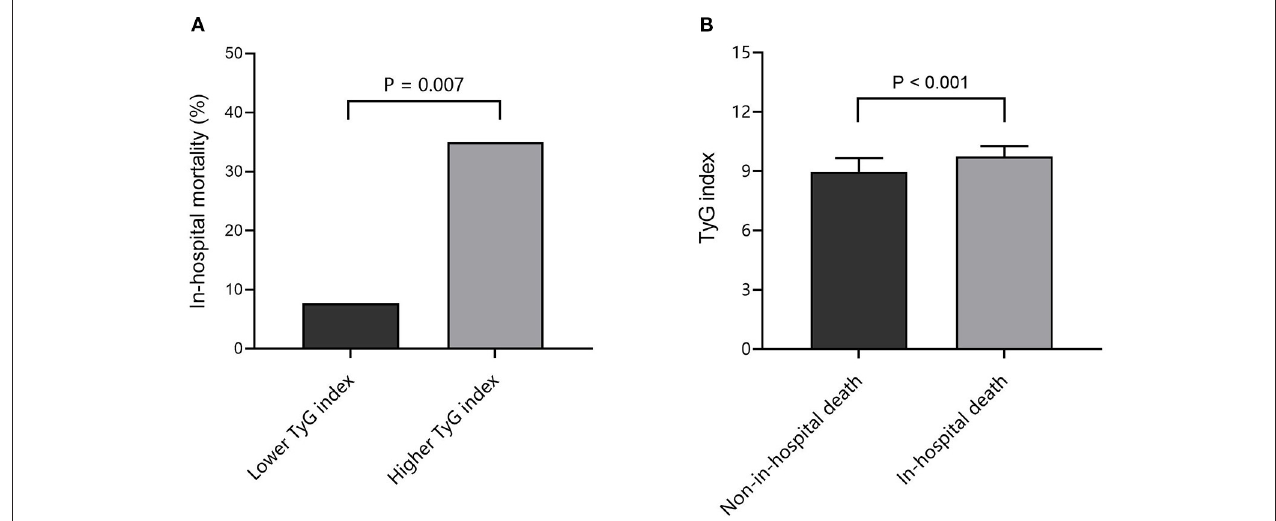
FIGURE 3 | Kaplan–Meier survival curves according to the median of TyG index. TyG, triglyceride-glucose.